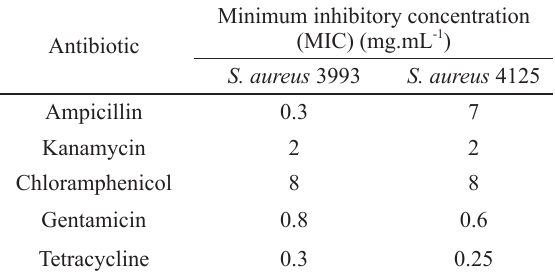
Values of minimum inhibitory concentrations (mg.mL -1 ) obtained for the tested